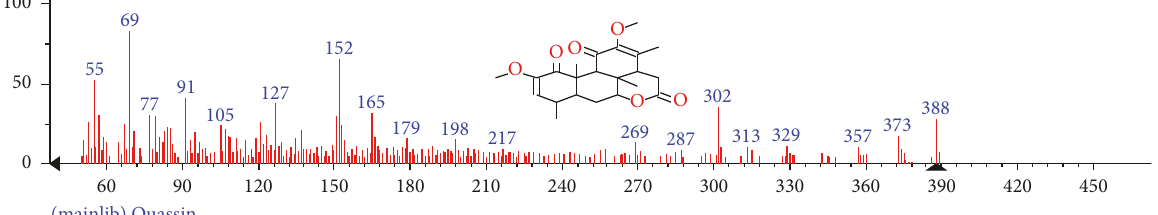
Figure 63: Mass spectrum of compound quassin of whole plant hexane fraction of Achillea wilhelmsii (WHFAW).